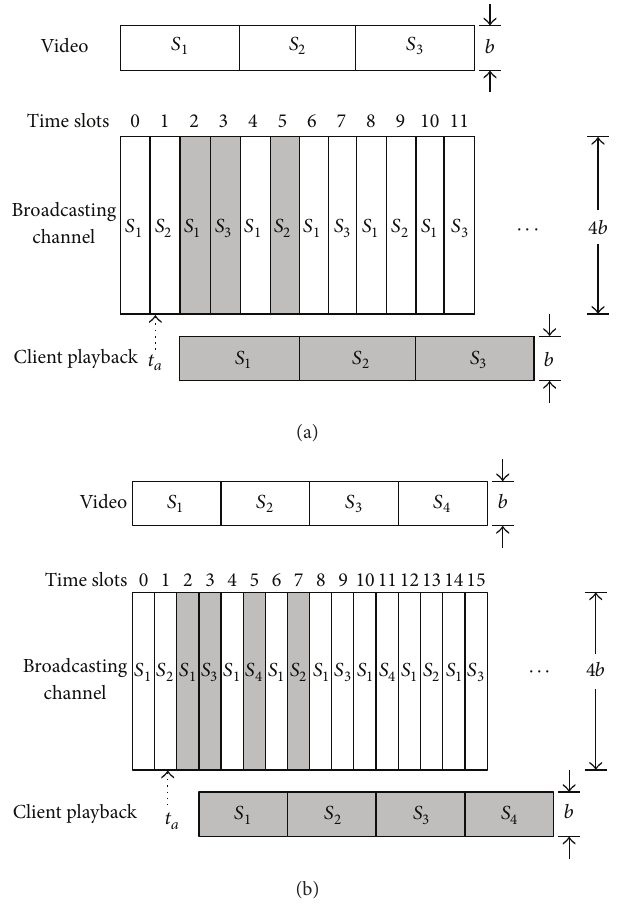
Figure 1: Segment partition and arrangement for AB.